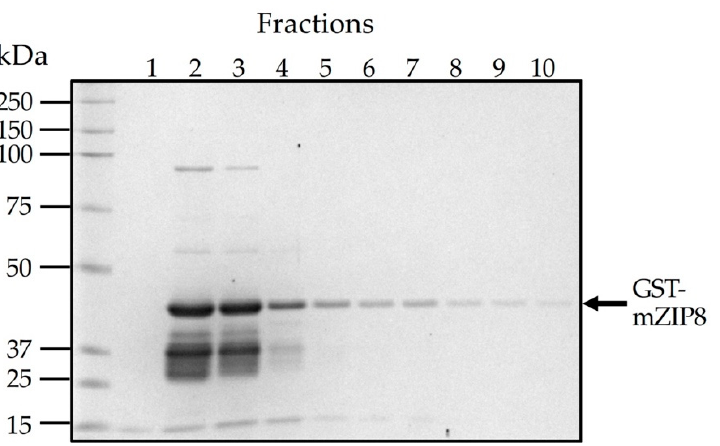
Figure 3. Purification of GST–NT ‐ mZIP8 fusion protein from E. Coli transformed with the pGEX ‐ 3X recombinant vector. An overnight culture of E. coli cells transformed with the pGEX ‐ 3X ‐ NT ‐ mZIP8 vector was diluted in fresh LB media and grown for 1 h. After adding IPTG to the culture at a final concentration of 1 mM, the culture was grown for an additional 3 h. Cells were lysed, and the lysates were applied to the glutathione sepharose to allow the binding of GST fusion pro ‐ teins. The elution buffer was added to elute the GST fusion proteins (10 consecutive fractions of the eluate were collected, 1 mL/fraction). SDS ‐ PAGE gel loaded with different fractions of GST– mZIP8 was stained with Coomassie blue.